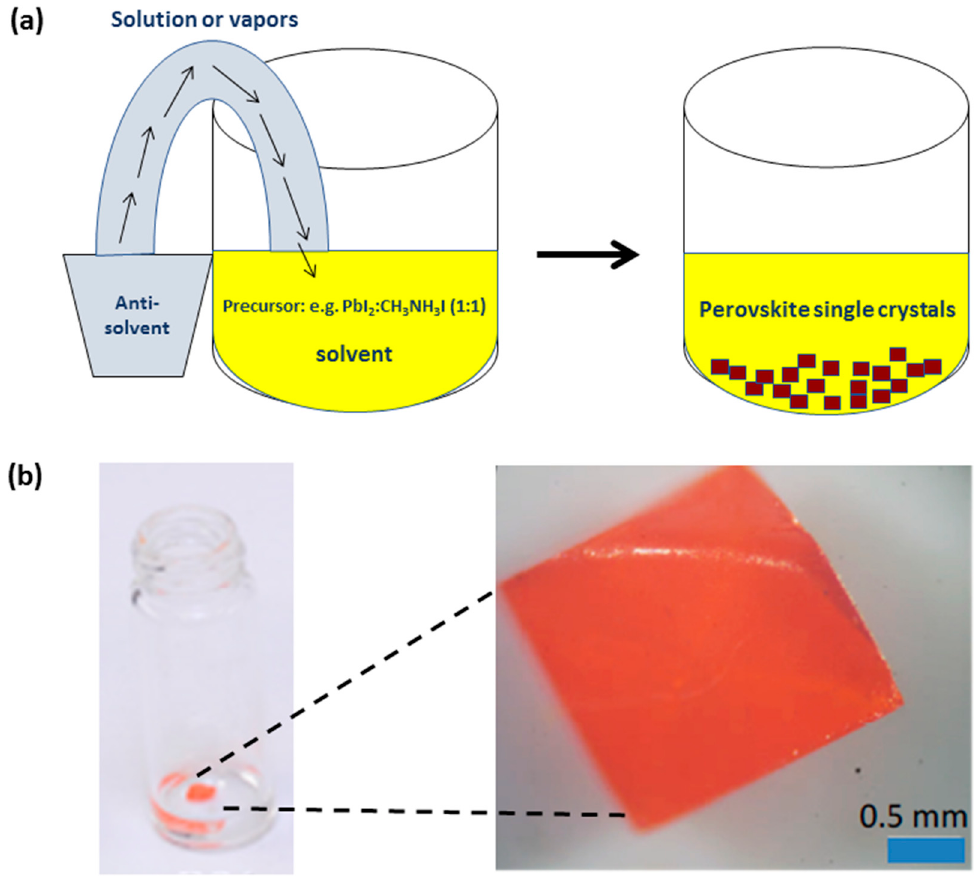
Figure 1. ( a ) A schematic diagram of a typical, anti-solvent crystallization process for MAPbI 3 perovskite formation. ( b ) A vial containing an orange single crystal of MAPbBr 3 , grown by the anti-solvent (IPA) crystallization method and optical microscope image of the crystal. Reprinted with permission from [21]. Copyright (2014) American Chemical Society.